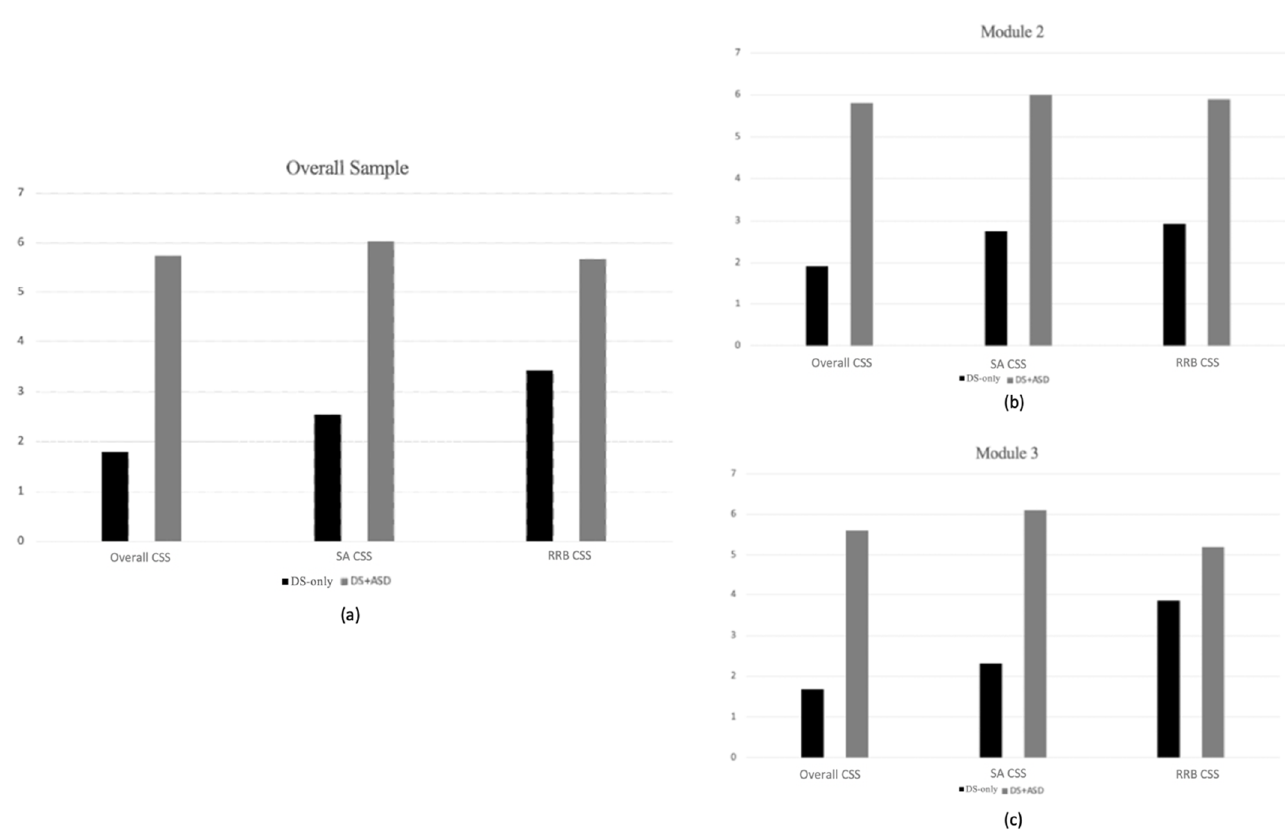
Figure 2. Group differences in mean ADOS-2 CSSs; ( a ) Group differences in mean ADOS-2 CSSs for overall sample; ( b ) Group differences in mean ADOS-2 CSSs for Module 2; ( c ) Group differences in mean ADOS-2 CSSs for Module 3.